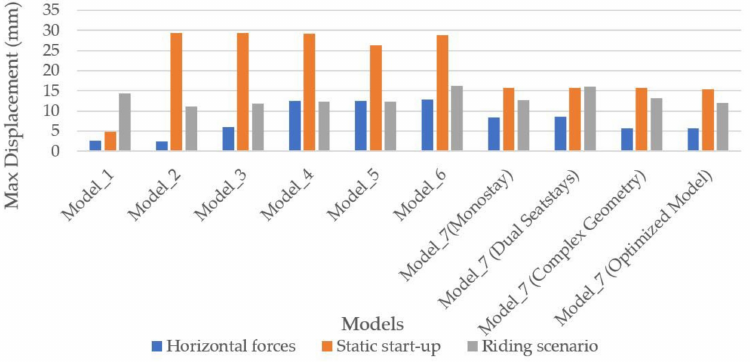
Figure 17. Maximum displacement per model in horizontal impact, in static start-up, and in riding scenarios.